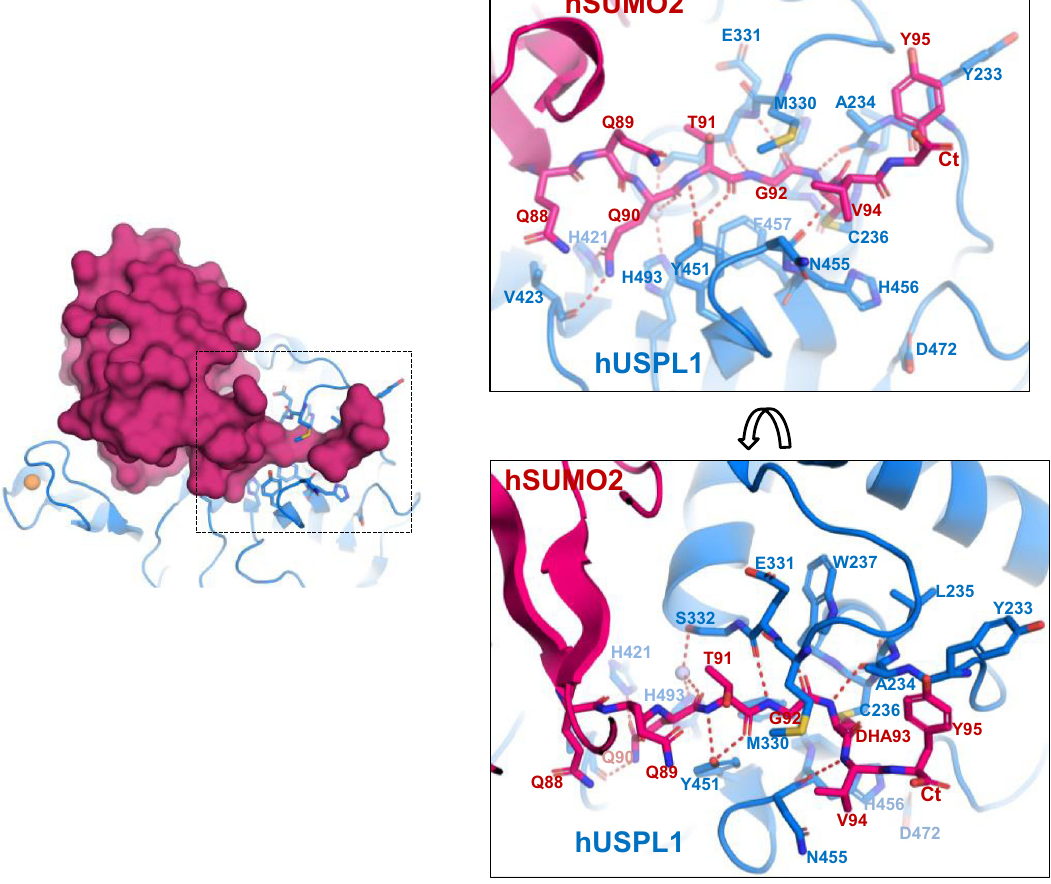
Fig. 4 Atomic details of the C-terminal tail interaction of SUMO2 with USPL1. Two views of the stick representation of the main contacts of the C-terminal of SUMO2 in complex with the active site groove of USPL1. USPL1 catalytic domain and SUMO2 are shown in blue and red, respectively. SUMO2 and USPL1 interface residues are labeled. Dashed lines indicate hydrogen bond contacts. On the left side, surface representation of SUMO2 (red) in complex with USPL1, shown in a blue cartoon. Interface residues are shown in stick representation. Zinc atom is shown in